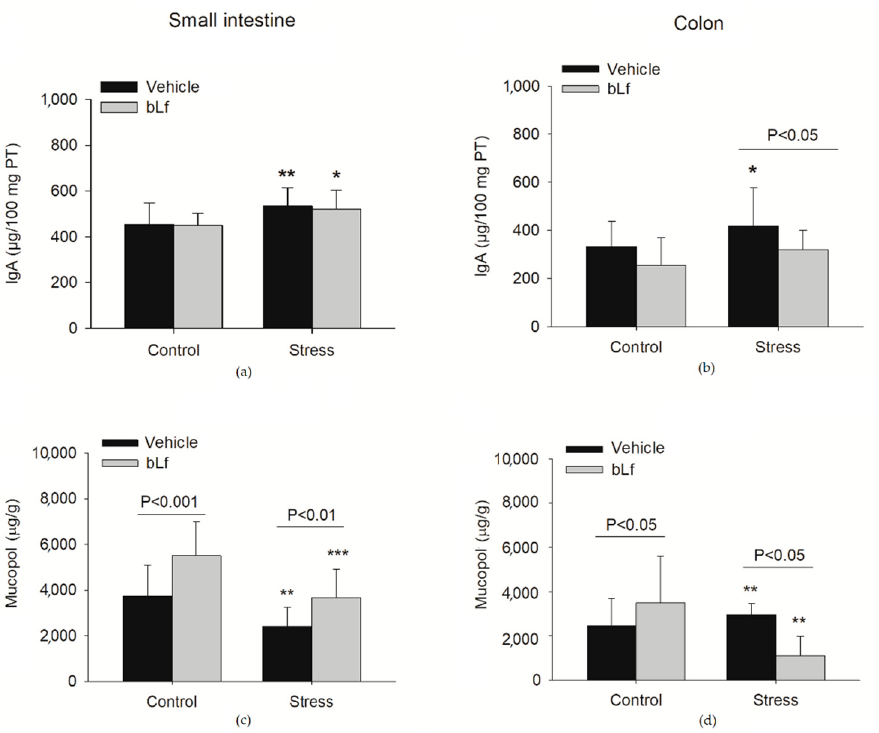
Figure 2. Outcome of stress on IgA and mucin mucopolysaccharides (Mucopol). The concentration of IgA ( µ g/100 mg of total protein [PT]) in ( a ) the small intestine and ( b ) the colon, and the concentration of mucopolysaccharides in ( µ g/g sample) ( c ) the small intestine and ( d ) the colon of mice that underwent immobilization stress for 2 h a day for 4 days. * p < 0.05, ** p < 0.01, and *** p < 0.001 indicate column comparisons between stressed and control unstressed groups. The p values over the lines indicate comparisons between the paired matched groups.